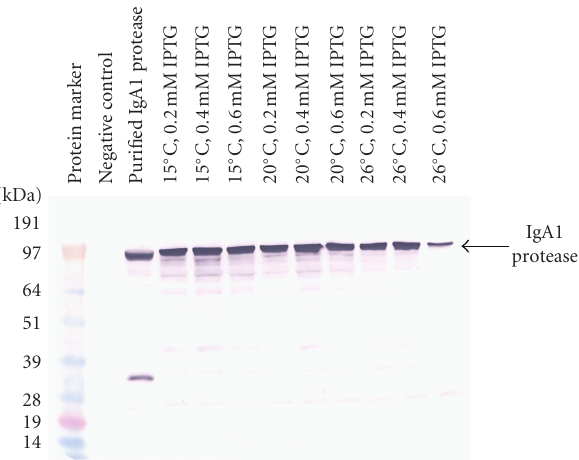
Figure 5: Expression of soluble IgA1 protease from pET-IGAN in C41 (DE3) strain. SDS-PAGE (reduced condition) and Western blotting with anti-His Ab were employed to confirm the expression of IgA1 protease. Negative control: un-induced pET-IGAN C41 (DE3) soluble supernatant; purified IgA1 protease: purified IgA1 protease from H. influenzae.